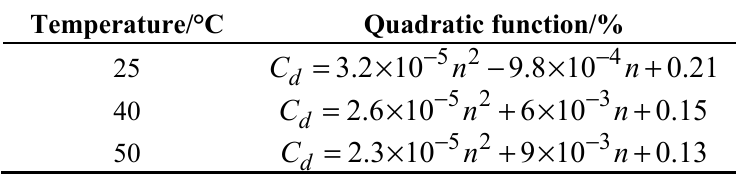
Table 1. Quadratic functions depicting the relationship between capacity reduction and the number of aging cycles.